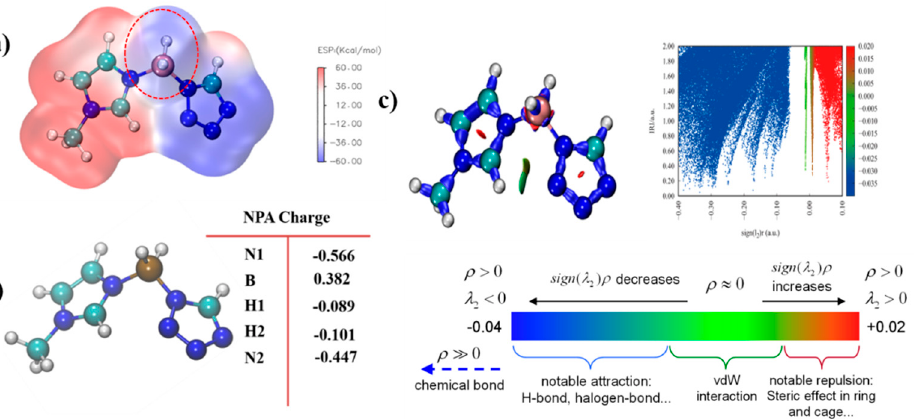
Figure 15. Electrostatic potential mapping of (1-methylimidazolium)(tetrazol-1-yl) borane ( a ); Nat- ural population analysis charges (NPA charge) of the (1-methylimidazolium)(tetrazol-1-yl)borane ( b ); Interaction region indicator (IRI) analysis of the (1-methylimidazolium)(tetrazol-1-yl) borane ( c ).